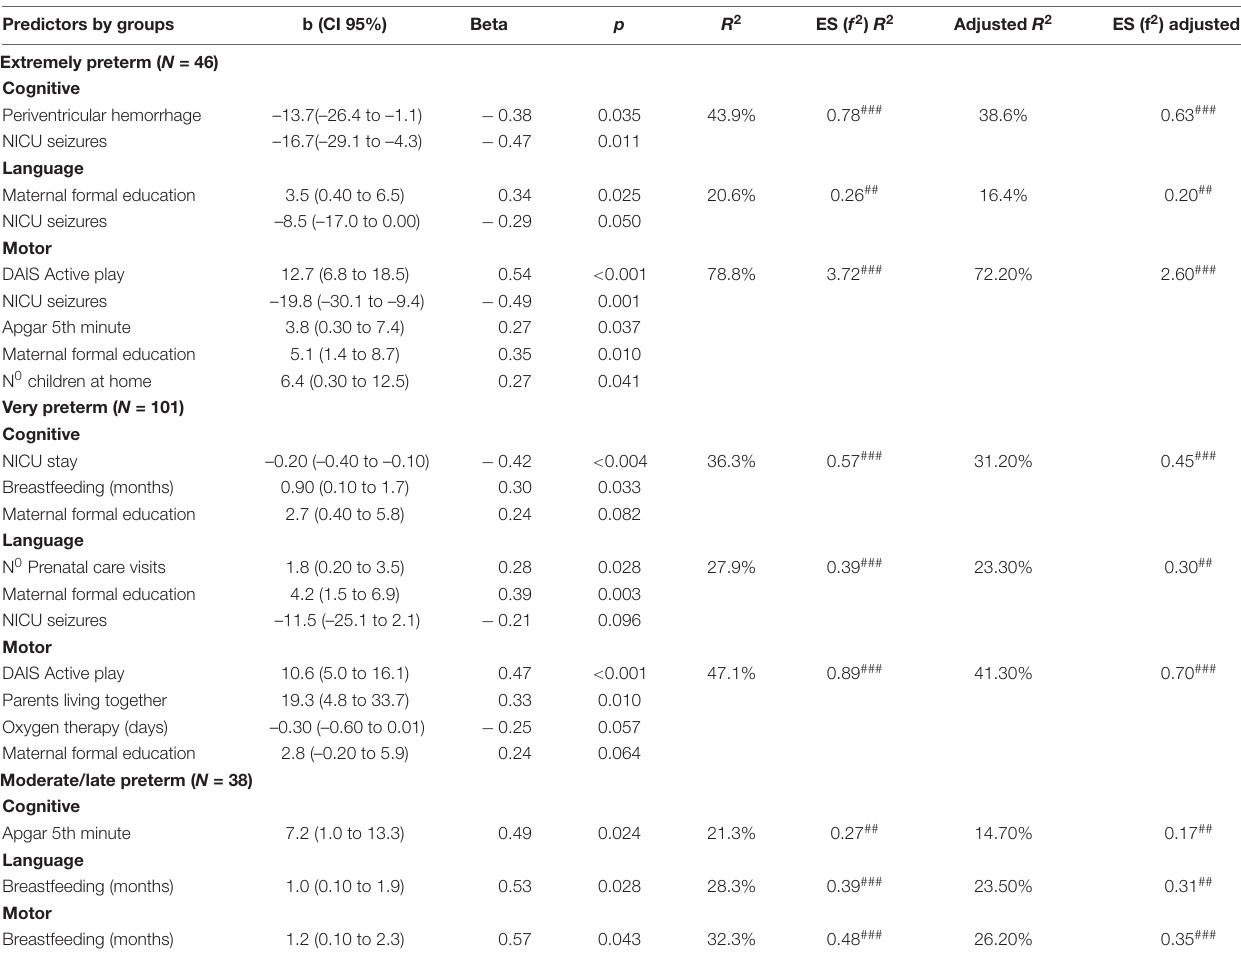
TABLE 7 | Linear multivariate regression by